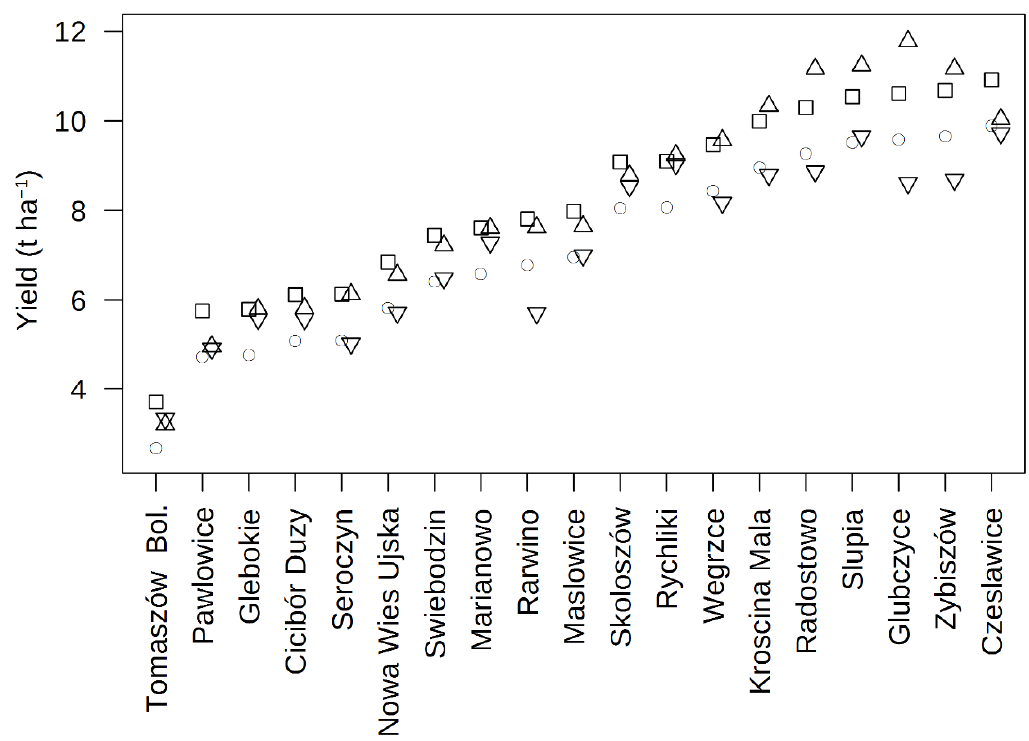
Figure 2. Estimated average yield (t / ha) in trial locations based on ANCOVA analysis. Triangles are the observed yield at the lower, a moderate-input management system (MIM) (vertex down) and the high-input management system HIM (vertex up) conditions. Circles and squares are the estimated yield for two levels of crop management intensity: moderate (MIM) and high (HIM), respectively.